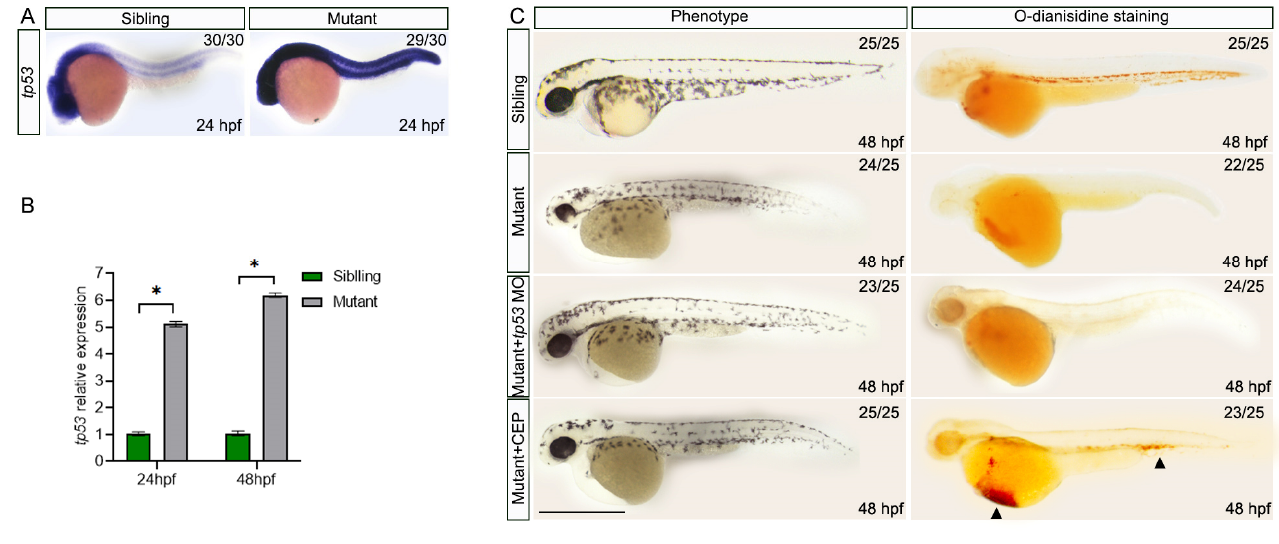
Figure 5. Knockdown of p53 and inhibition of jak2 partially rescue malformation and anemia in nop56 mutants. ( A ) WISH analysis of p53 in siblings and mutants. ( B ) qRT-PCR showed that p53 expression was increased significantly in nop56 mutants. qRT-PCR was performed with biological repeats and technical repeats in triplicate. n = 3, * p < 0.05. ( C ) Analyses of the phenotype and hemoglobin level after p53 knockdown and CEP-33779 treatment in nop56 mutants. Knockdown of p53 partially rescued the morphological malformations, but not anemia, at 48 hpf. However, CEP-33779 partially rescued the anemic phenotype, but not malformations, at 48 hpf. Arrowhead indicates erythroid cells. All scale bars represent 1 mm.